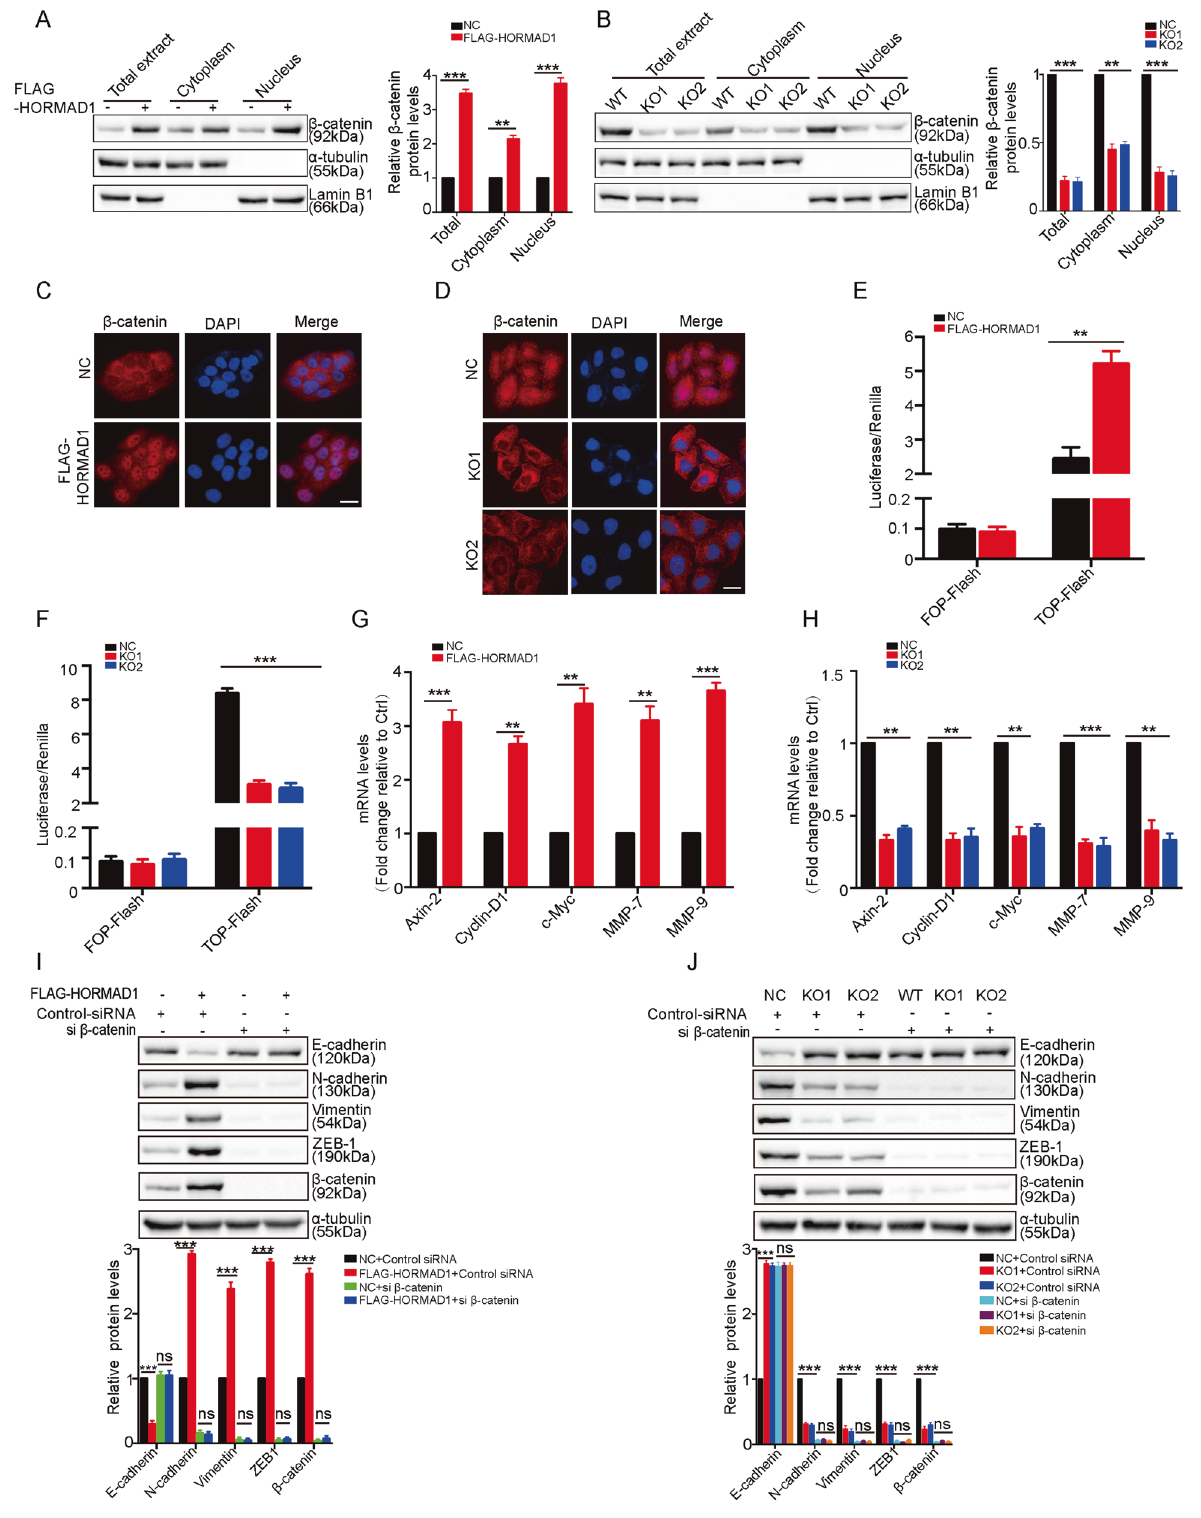
H125 cells after HORMAD1 overexpression. Conversely, the amounts of β -catenin in the cytosol and nucleus were signi fi cantly decreased in H650 and H2170 cells after HORMAD1 KO (Figs. 5A, B, S3A, B). Moreover, immuno fl uorescence assay was performed to detect the subcelluar localization of β -catenin. The results indicated that HORMAD1 overexpression in H157